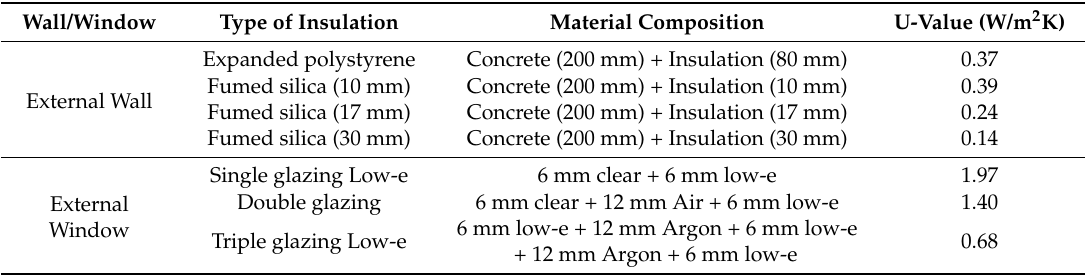
Table 4. Details of external wall and window material